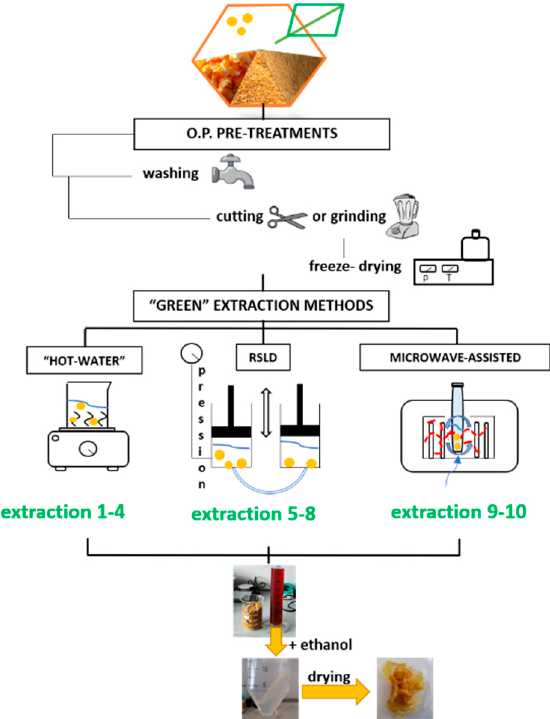
Figure 1. Scheme of the extraction routes investigated in this study: “hot-water”, rapid solid liquid dynamic extraction and microwave digester.